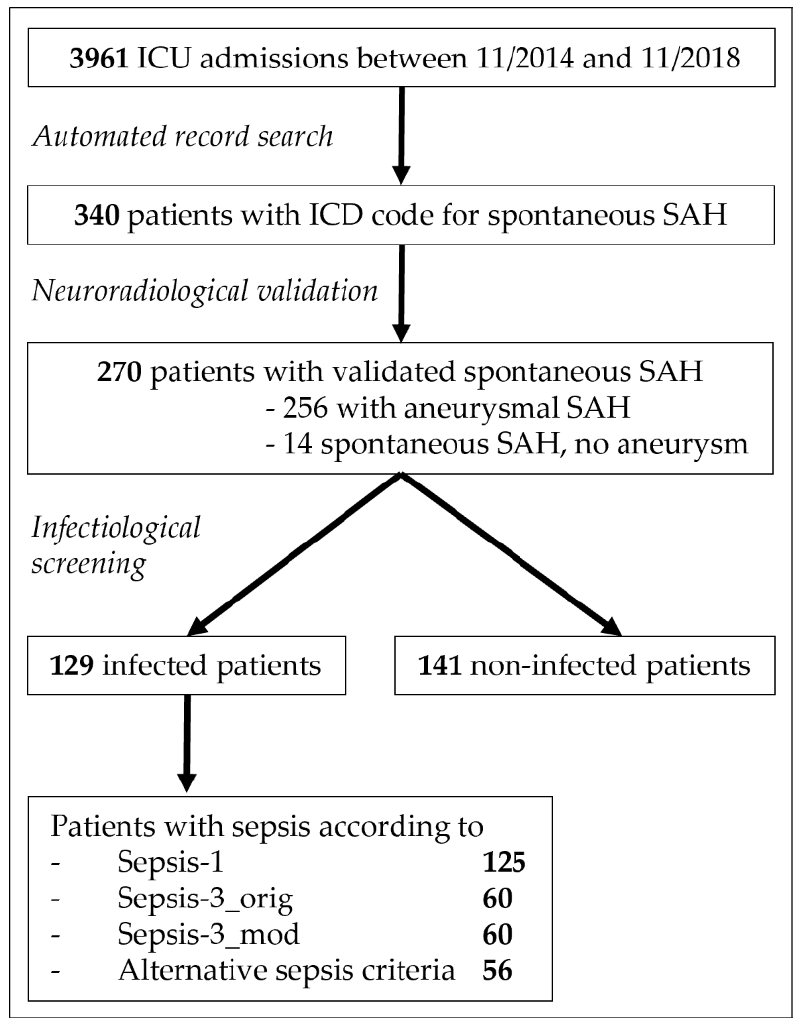
Figure 1. Flow chart of study cohort selection. Intensive Care Unit (ICU), International Classification of Diseases (ICD), subarachnoid hemorrhage (SAH).